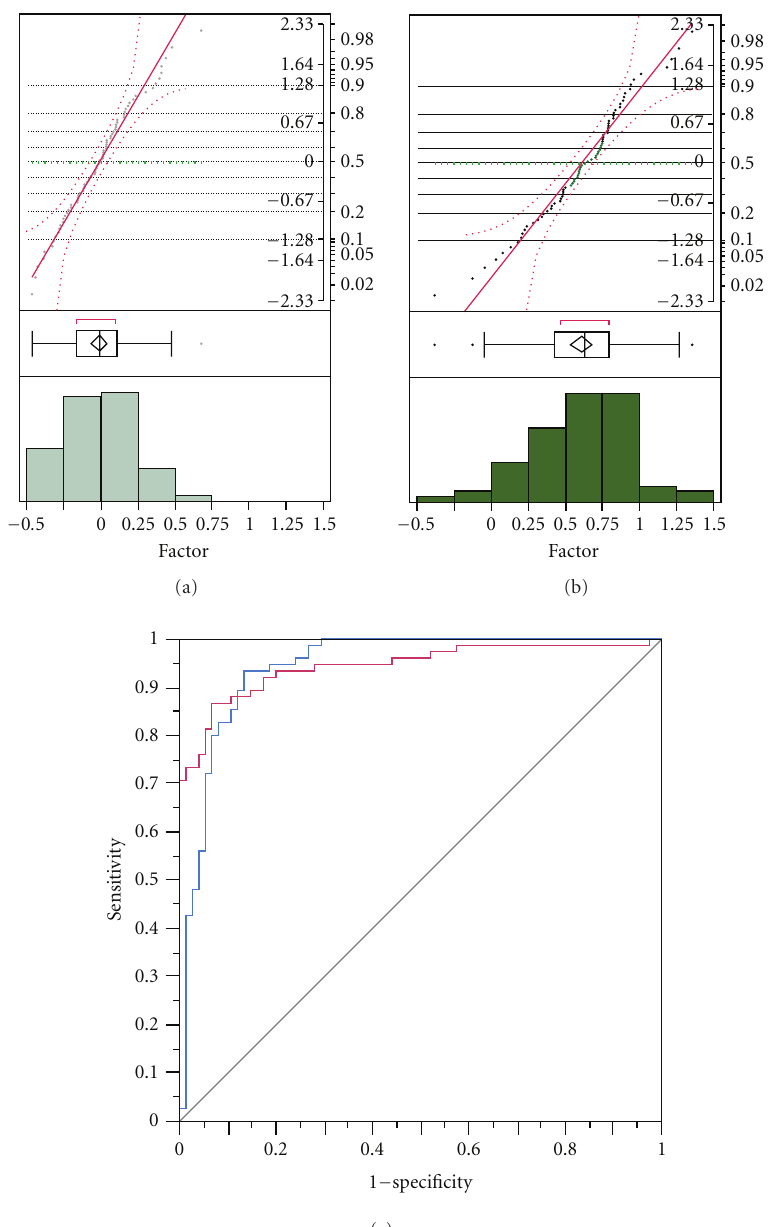
Figure 1: (a, b) Distributions of morphological factors for the CTRL (a) and probable AD groups (b) alongside quantile plots based on the Gravitational model (see Section 2.5.4). (c) Receiver operating characteristic curve (ROC) for the morphological factor displaying the trade-o ff s between sensitivity and specificity at the task of discriminating CTRL versus probable AD. The area under the ROC curve was 0.9444. At the 90% accuracy point (135/150), specificity was 87.5% and sensitivity